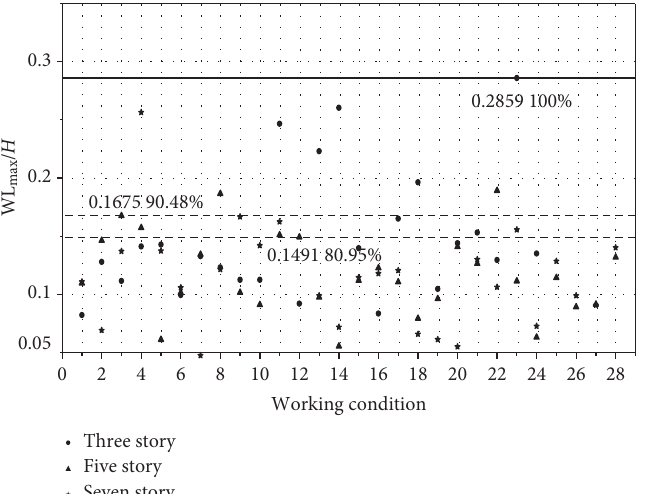
Figure 27: Statistic of the maximum influence width coefficient of the masonry structure along the X axis under the continuous collapse mode of various working